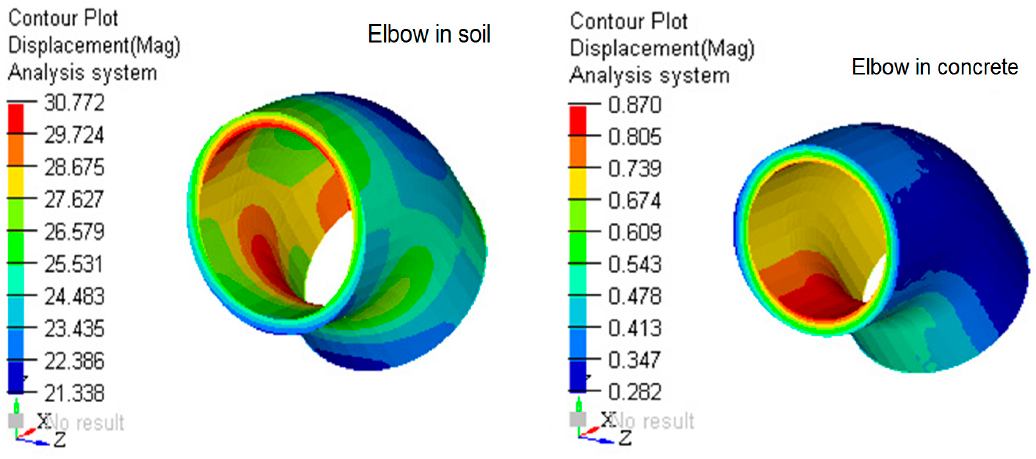
Figure 20. Displacements in elbow, in mm (load pressure 50 MPa).